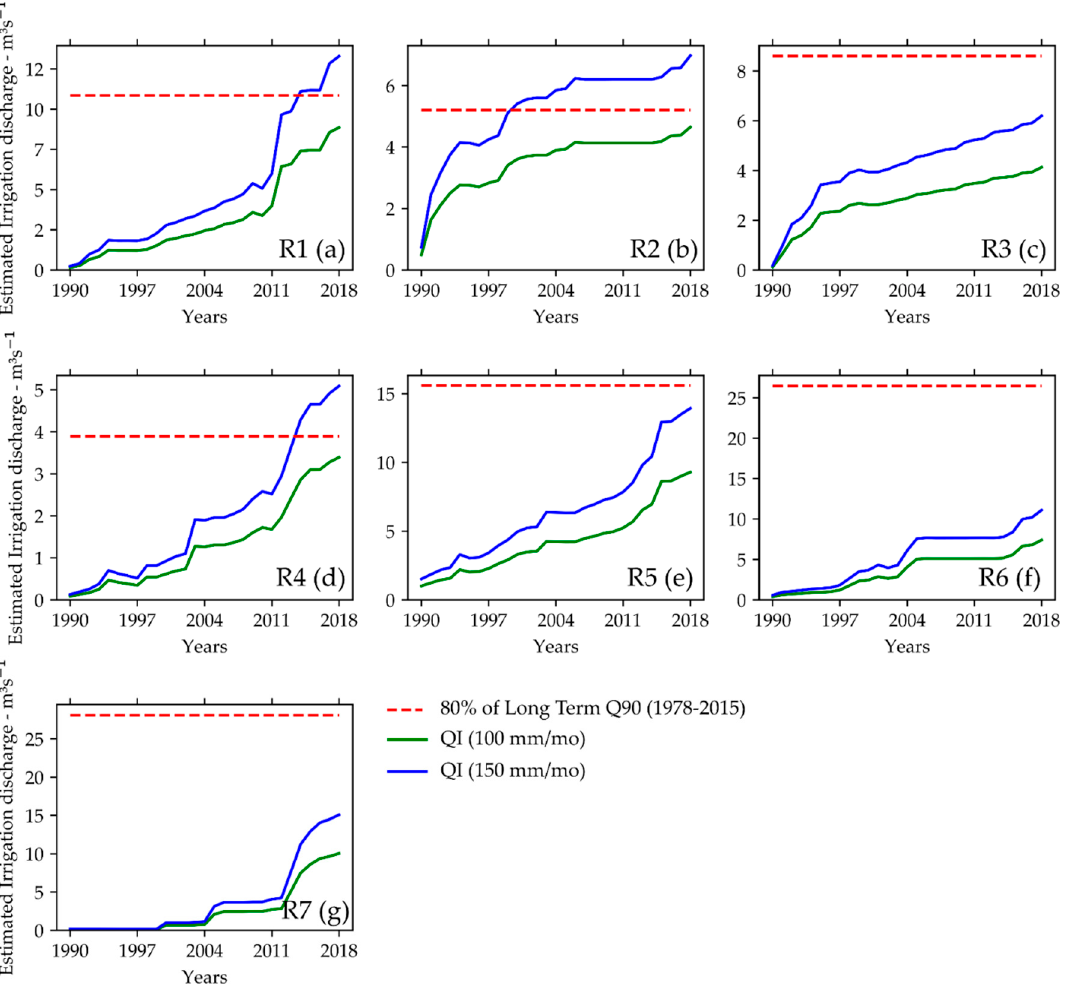
Figure 11. Scenarios of discharge uptake for irrigation in selected regions, assuming two water application rates (100 and 150 mm / month). 80% of long-term Q 90 is the maximum river discharge that can be granted permission for human use [17].